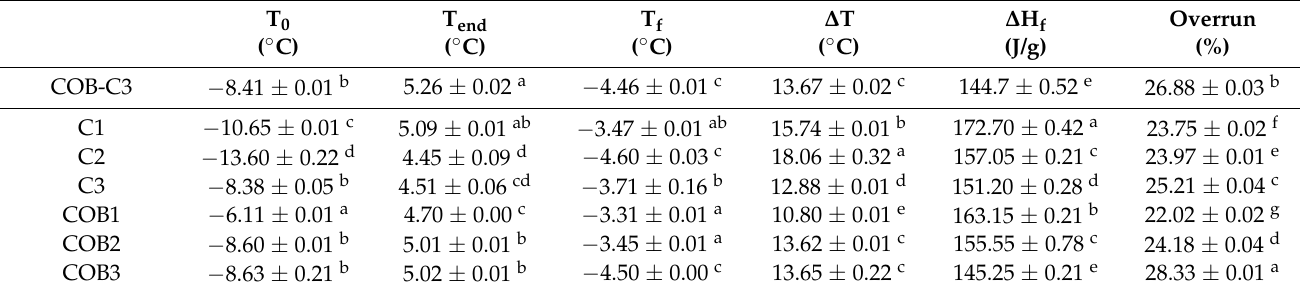
Table 6. Thermal properties and overrun of the ice cream